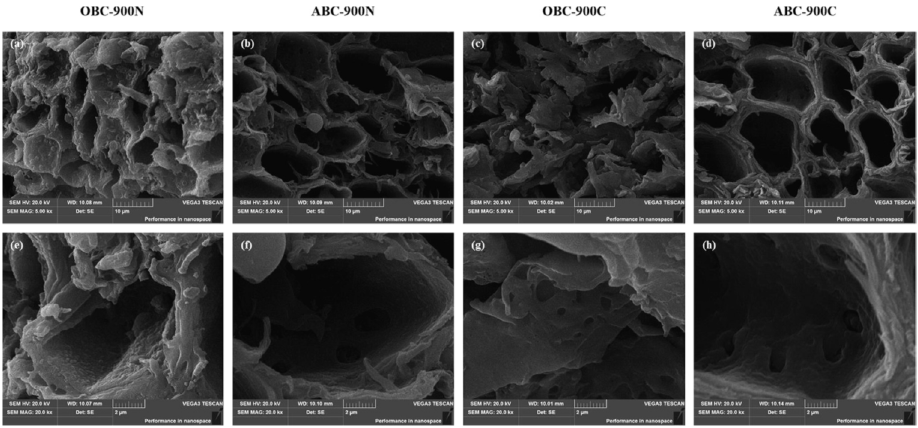
Figure 3. SEM images of activated carbon derived from oak tree and apple tree wood waste (( a – d ): 5000× magnification; ( e – h ): 20,000× magnification). Reproduced with permission from [12], ©2020 Elsevier B.V.